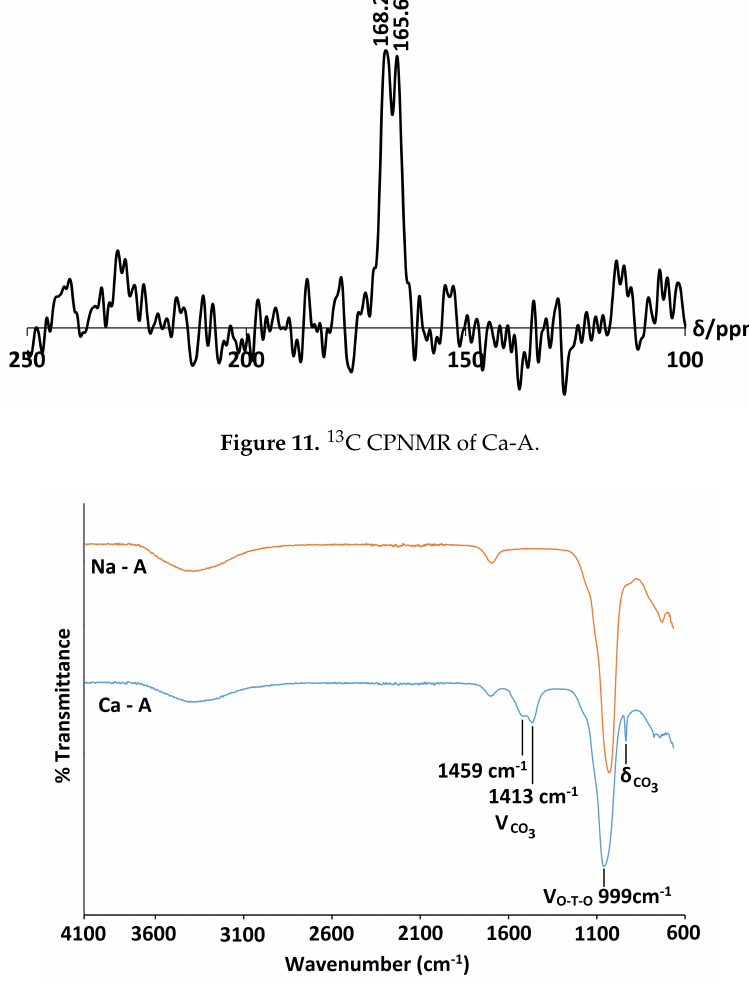
Figure 12. FT-IR spectra for the parent Na-A zeolite (orange) and Ca-A